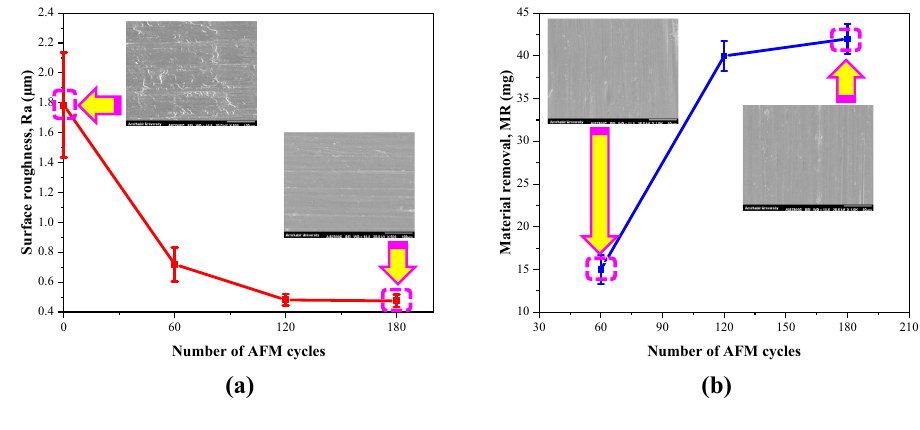
Fig. 4 Effects of the number of AFM cycles on a the Ra value and b the MR